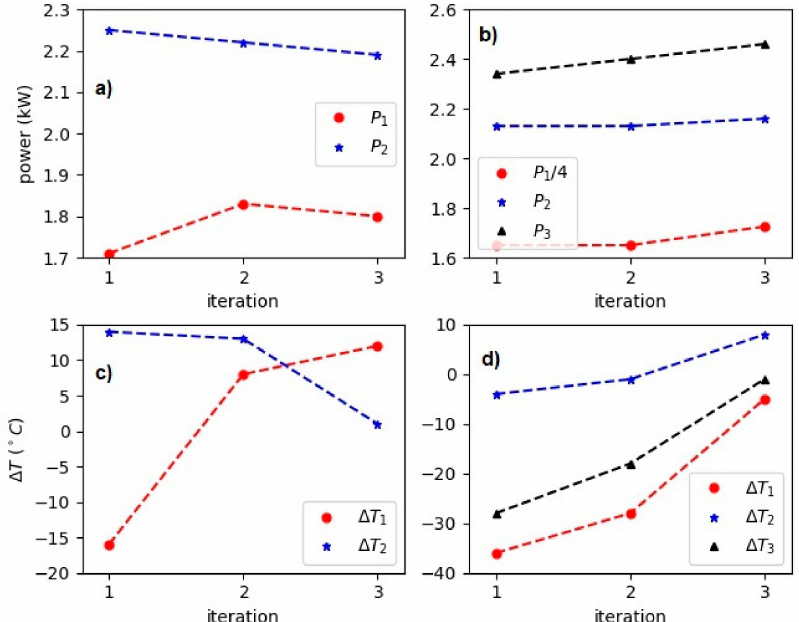
Figure 9. ( a ) Power level of each iteration for the control experiment with two target temperatures ( T = {500, 900 } ◦ C). ( b ) Power level of each iteration for the control experiment with three target temperatures ( T = {700, 825, 1030 } ◦ C). ( c ) Error in the target temperature for each iteration for the control experiment with two target temperatures. ( d ) Error in the target temperature for each iteration for the control experiment with three target